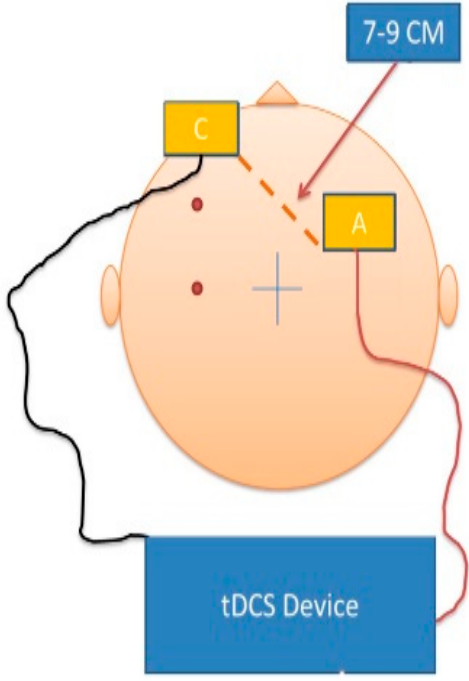
Figure 2. Schematic demonstrating placement of the transcranial direct current stimulation (tDCS) cathodal (C) and anodal (A) electrodes.